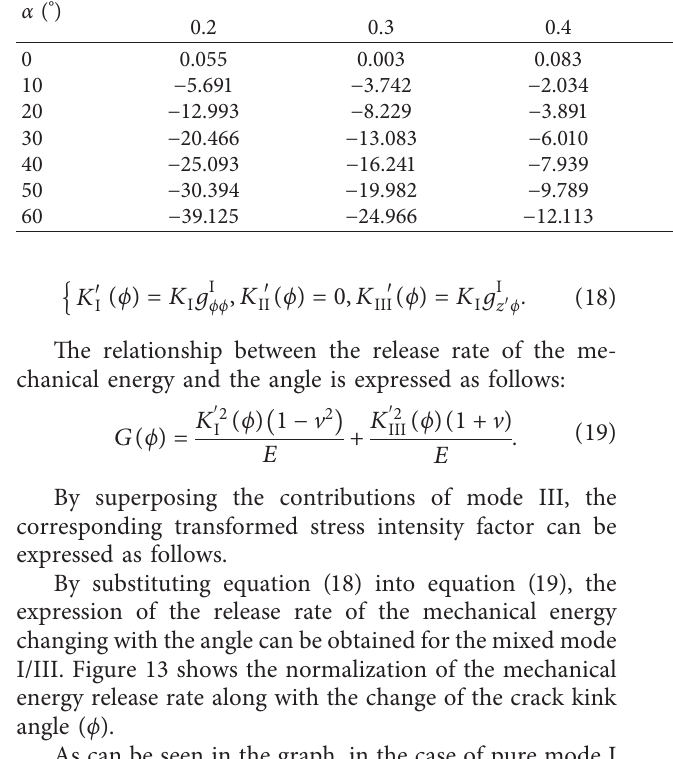
Table 2: Variations of kink angle with α between 0.2 and 0.8 at the crack front. α ( ° )